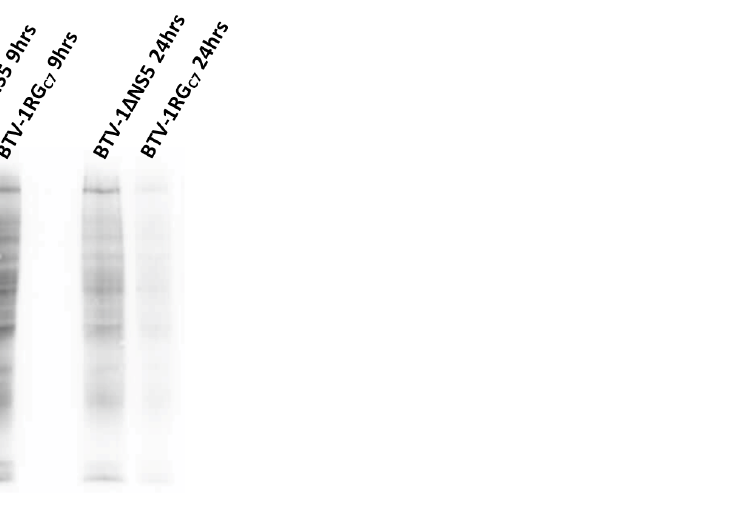
Figure 16. Pulse and chase puromycin labelling of cells infected with BTV-1RG C7 or BTV-1 ∆ NS5. BSR cells infected with BTV-1RG C7 or BTV-1 ∆ NS5 were pulse-labelled with puromycin for 15 min at 9 or 24 h post-infection (as indicated), then harvested 3 h later. Western blot analysis was performed using a monoclonal anti-puromycin antibody. NI indicates analysis of non-infected cells.